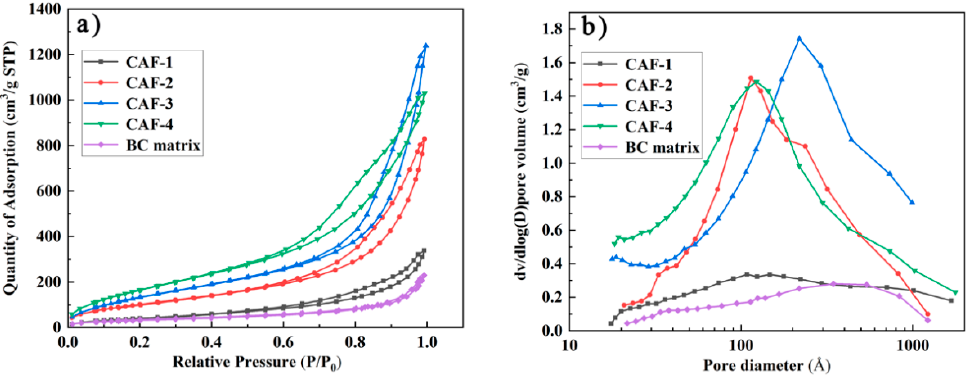
Figure 5. Nitrogen adsorption–desorption ( a ) isotherms and pore size distribution ( b ) of CAFs.